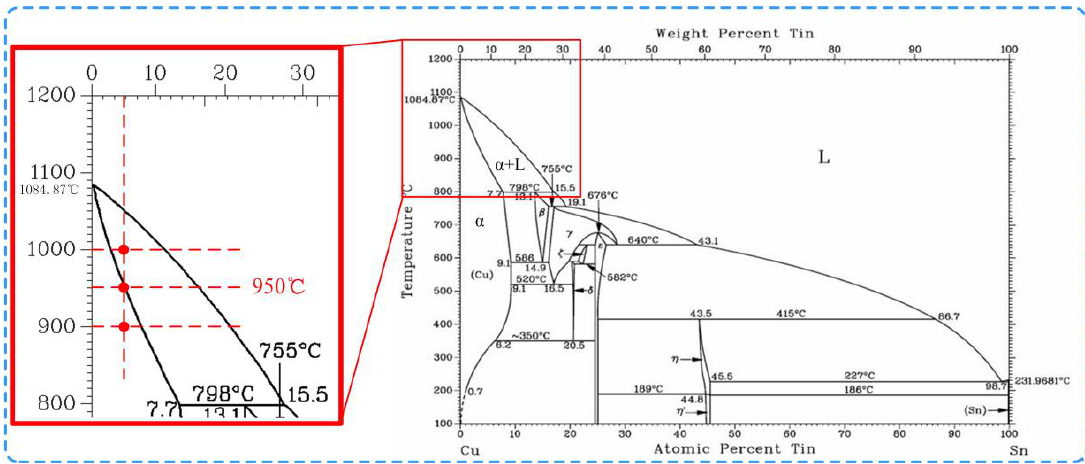
Figure 5. Cu-Sn phase diagram [30].